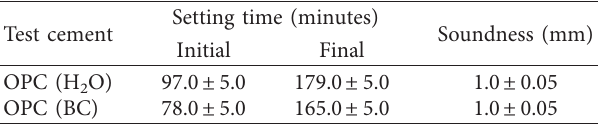
Table 2: Setting time and soundness for the control and microbial samples. Test